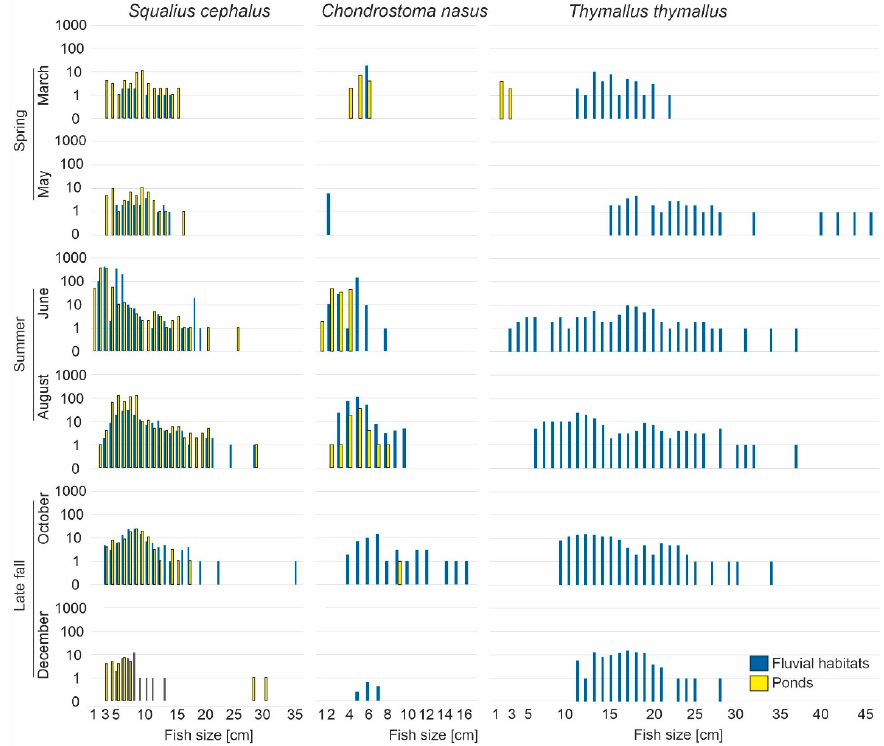
Figure 6. Length-frequency-distribution of Squalius cephalus , the most persistent fish species, as well as two other species with high conservation and indicator value, Thymallus thymallus and Chondrostoma nasus , in fluvial habitats (blue bars) and ponds (yellow bars), for the different sampling months between March and December and the seasons spring, summer, and late fall. Bars represent the sum of caught